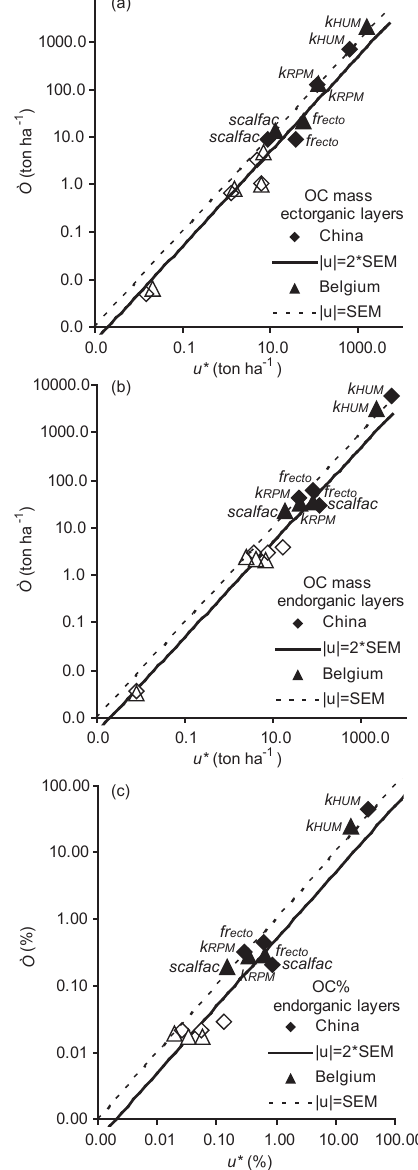
Fig. 3. Estimated means ( µ ∗ ) and standard deviations ( σ) of the distribution of elementary effects of factors on OC. (a) OC mass in ectorganic layers; (b) OC mass in endorganic layers; (c) OC con- tent in endorganic layers. Closed symbols with names indicate the 4 most important